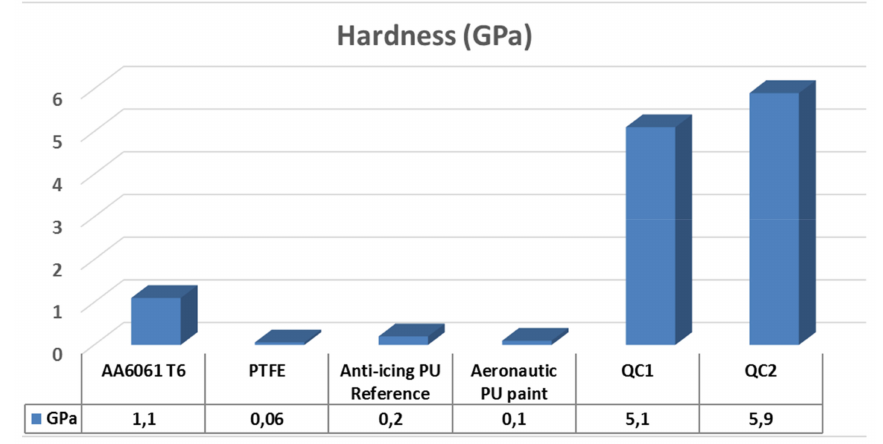
Figure 8. Vickers microhardness measured in all tested materials.